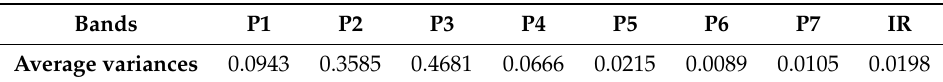
Table 2. For each spectral band, we show the average of the variances, computed at each point of these curves, around the average